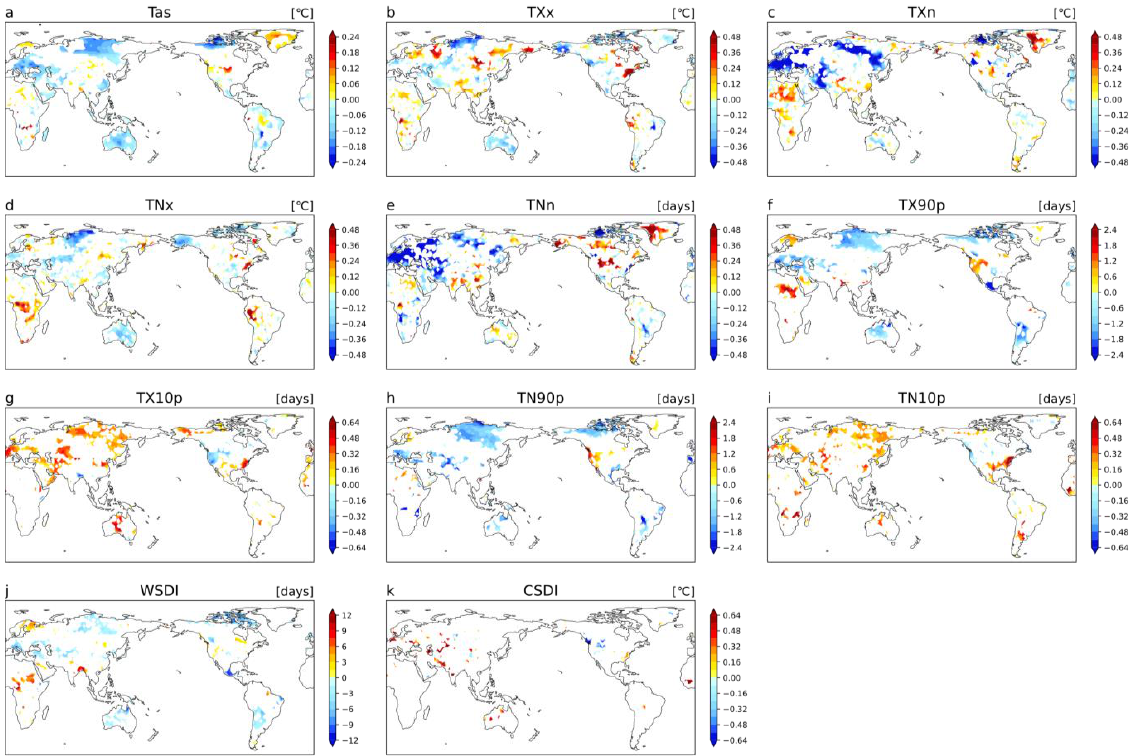
Figure 1. Under SSP1-2.6 scenario, the multi-model ensemble spatial patterns of the impact of land use change (i.e., ssp126-ssp370lu−ssp126) on future temperature extremes. Extreme climate indices are averaged over 2070–2099. Only grid points where at least 70% of the selected CMIP6 models simulate the same anomaly sign are shown. ( a ) mean temperature, ( b ) TXx, ( c ) TXn, ( d ) TNx, ( e ) TNn, ( f ) TX90p, ( g ) TX10p, ( h ) TN90p, ( i ) TN10p, ( j ) WSDI, ( k ) CSDI.